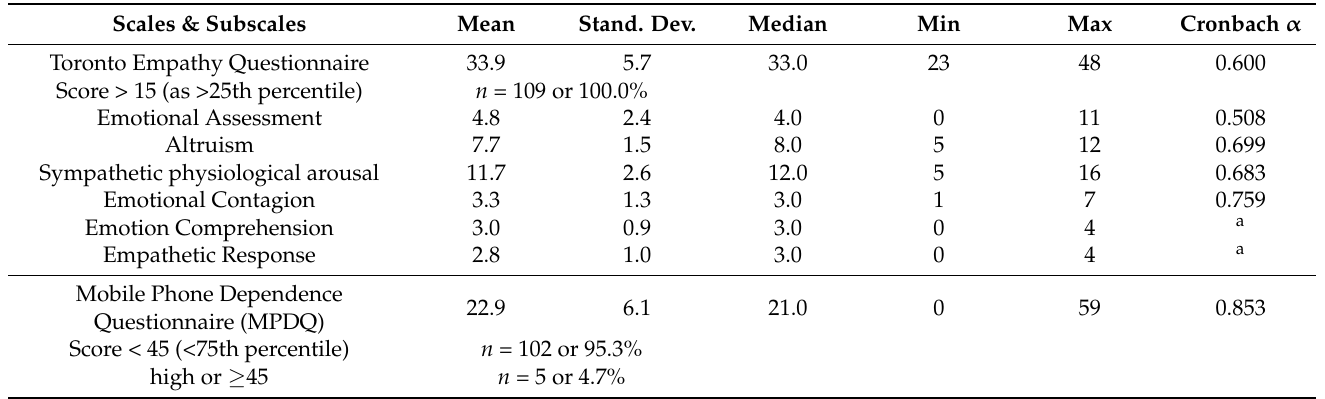
Table 2. Score levels and reliability of Empathy and Dependence scales in study participants. Scales &